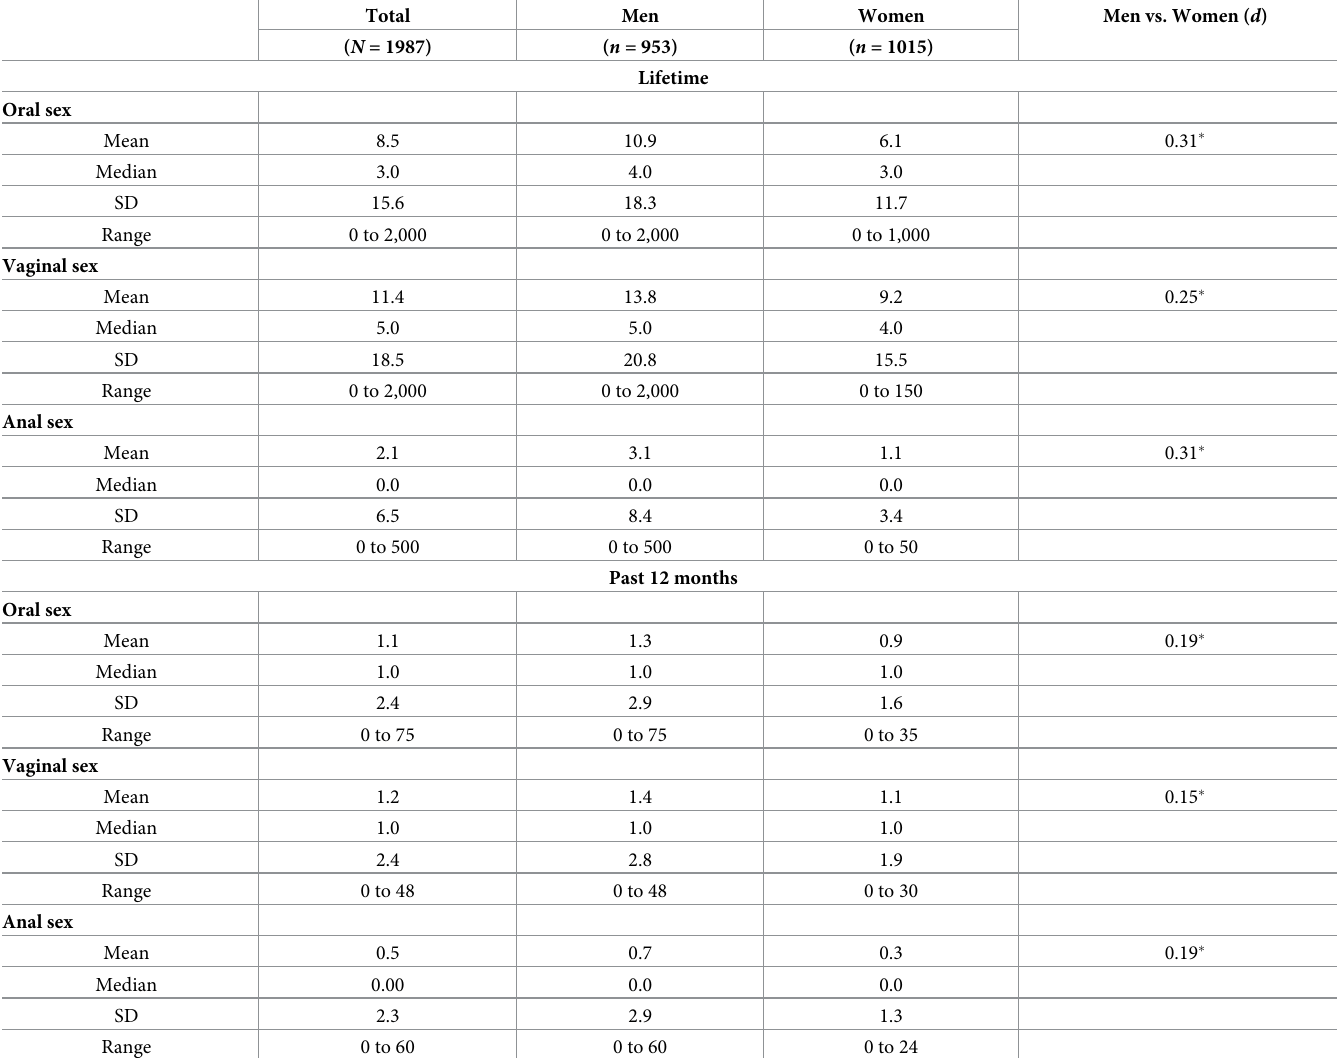
Table 4. Number of oral, vaginal, and anal sex partners for lifetime and past 12 months.